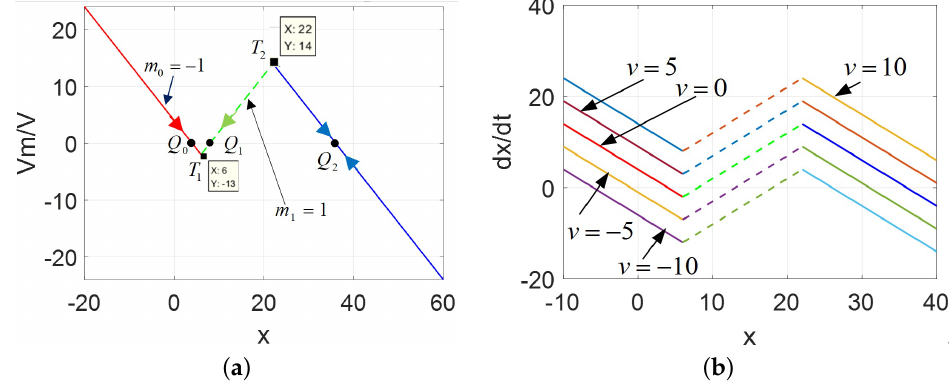
Figure 6. The DRM of 2-lobe CCM, A = A FL > A M : ( a ) DRM for the POP; ( b ) DRM for v =